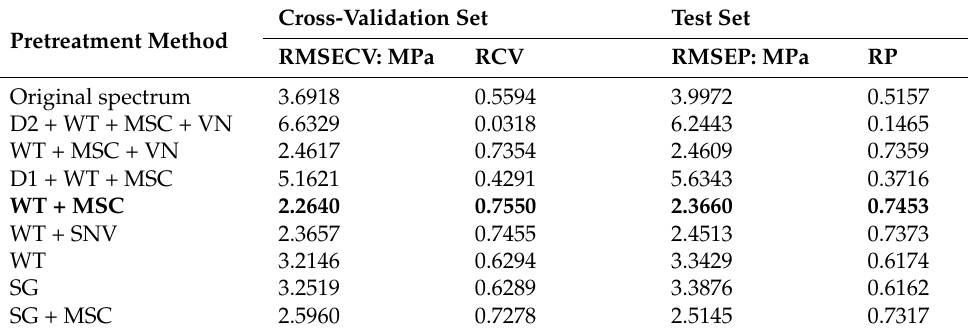
Table 4. Comparison of results of spectral preprocessing methods for